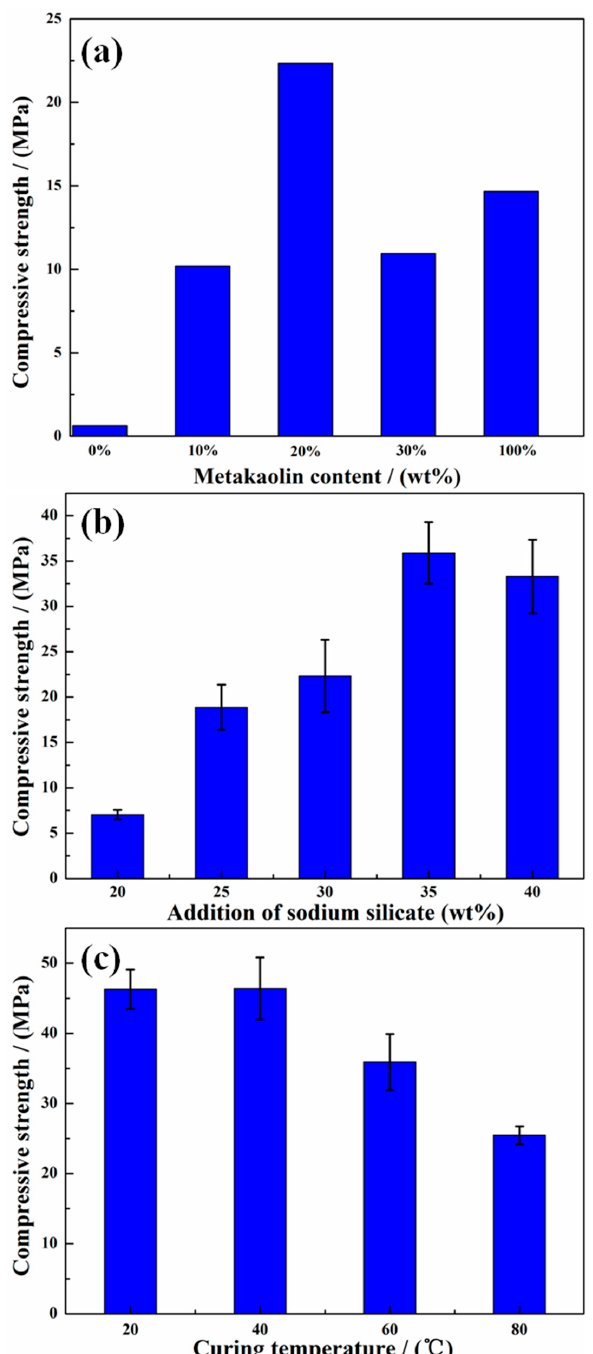
Figure 4. The compressive strength test results of samples with different metakaolin content cured for 3 days at 60 °C with 30% sodium silicate addition ( a ), under different sodium silicate additions cured for 3 days at 60 °C with 20% metakaolin content ( b ) and under different curing temperature for 3 days with 20% metakaolin content and 30% sodium silicate addition ( c ).